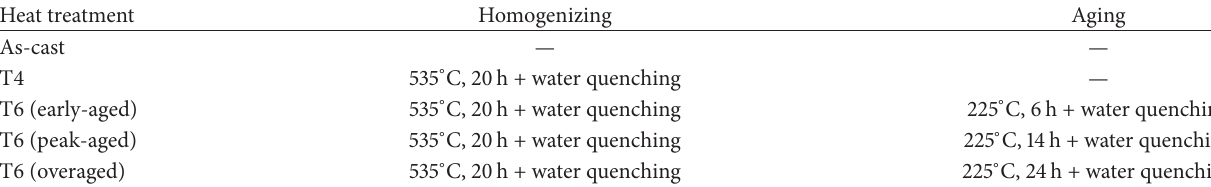
Table 1: Thermal process of the Mg-5Y-1.5Nd alloys in this